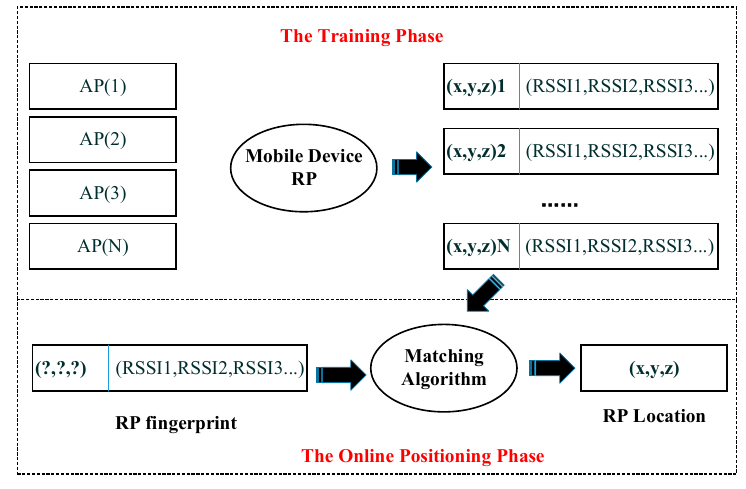
Figure 1. Fingerprinting-based Positioning method.